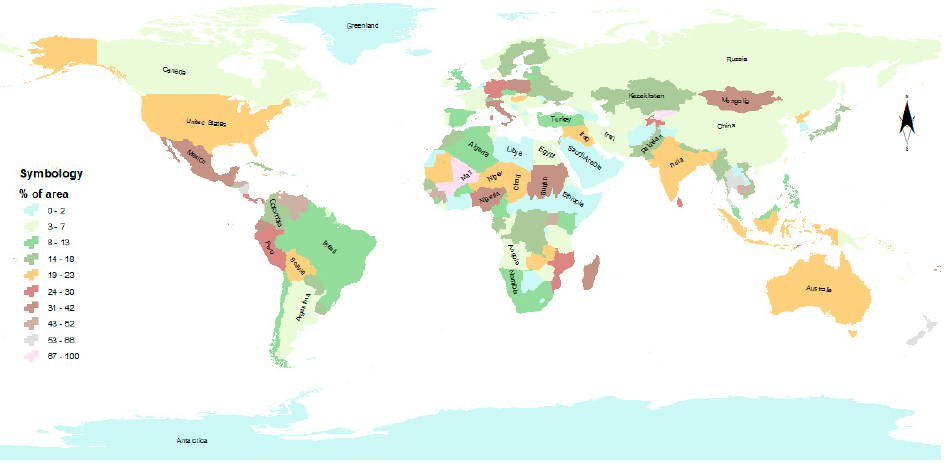
Figure 1. Percentage of protected area per country in 2015 in relation to its total forest area. Own elaboration with information of